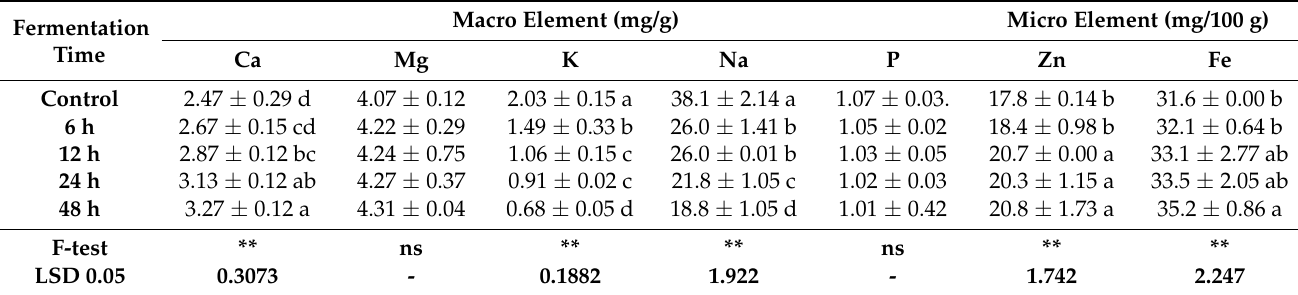
Table 2. Effect of natural fermentation on the mineral content of “Nabag” ( Ziziphus spina-christi L.) seeds. Fermentation